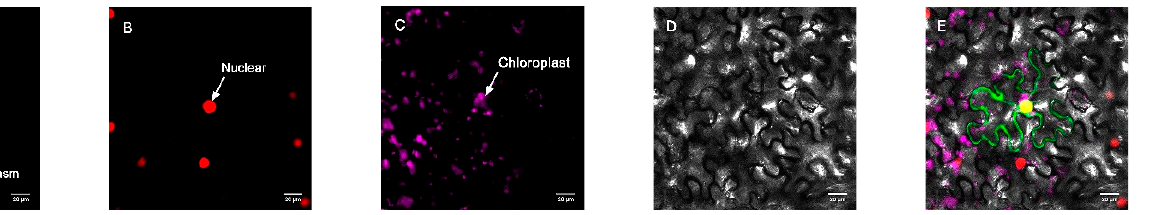
Figure 4. Target protein. ( A ) Fluorescence channel. ( B ) Marker fluorescence channel. ( C ) Chloroplast fluorescence channel. ( D ) Bright field. ( E ) Superimposed plot.